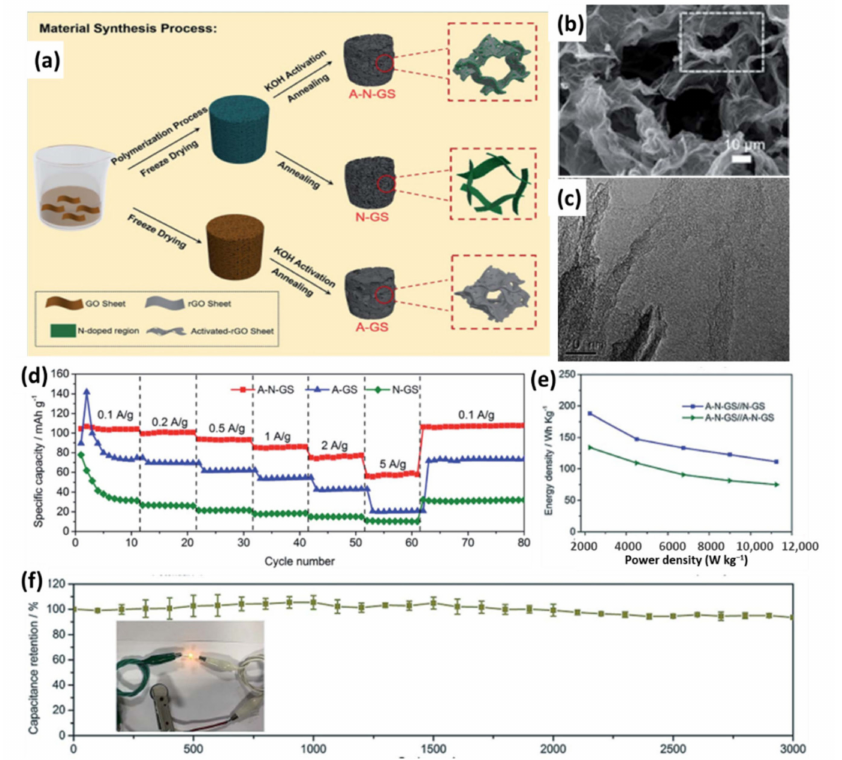
Figure 9. ( a ) Schematic illustration of the synthesis of A-N-GS, A-GS and N-GS; ( b ) SEM and ( c ) TEM images of A-N-GS; ( d ) Rate performance of A-N-GS, A-GS and N-GS; ( e ) Ragone plots of A-N- GS//N-GS and A-N-GS//A-N-GS LICs; ( f ) Cycle performance of A-N-GS//N-GS LICs. (Reprinted with permission from Ref. [120]. Copyright 2019 Royal Society of